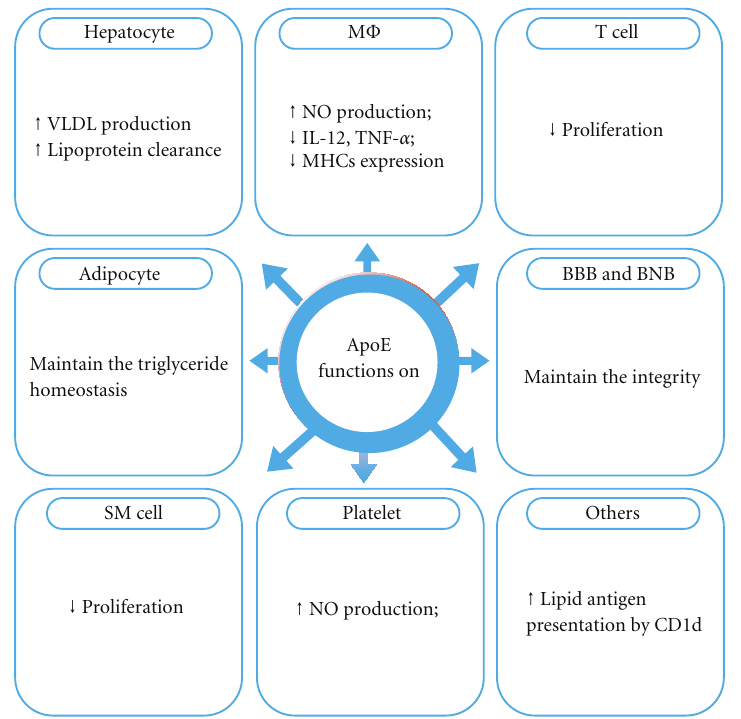
Figure 1: Schematic illustration of the biological properties of apoE. ApoE acts on adipocytes to maintain the triglyceride homeostasis; acts on hepatocytes to promote very low density lipoprotein (VLDL) production and lipoprotein clearance; modulates the functions of macrophages (M Φ ); suppresses the proliferation of T cells; maintains the integrity of blood-brain barrier (BBB) and blood-nerve barrier (BNB); inhibits the proliferation of smooth muscle (SM) cells; upregulates the production of nitric oxide (NO) of platelets; facilitates the presentation of lipid antigen by CD1 molecules to natural killer T (NKT) cells; and so forth. ↑ denotes upregulation or induction; ↓ downregulation or inhibition; IL denotes interleukin; TNF- α denotes tumor necrosis factor alpha; MHC denotes major histocompatibility